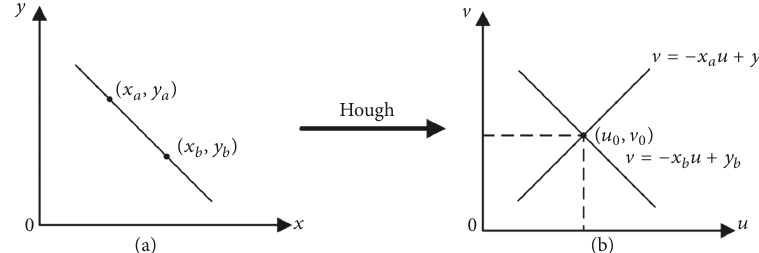
Figure 2: Hough transform. (a) A line in a Cartesian coordinate system and (b) spatial parameters after Hough transformation.